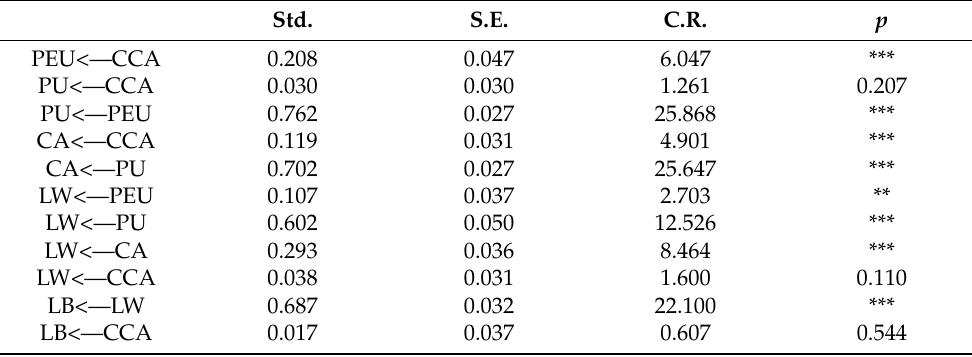
Table 5. Pathway hypothesis test results.